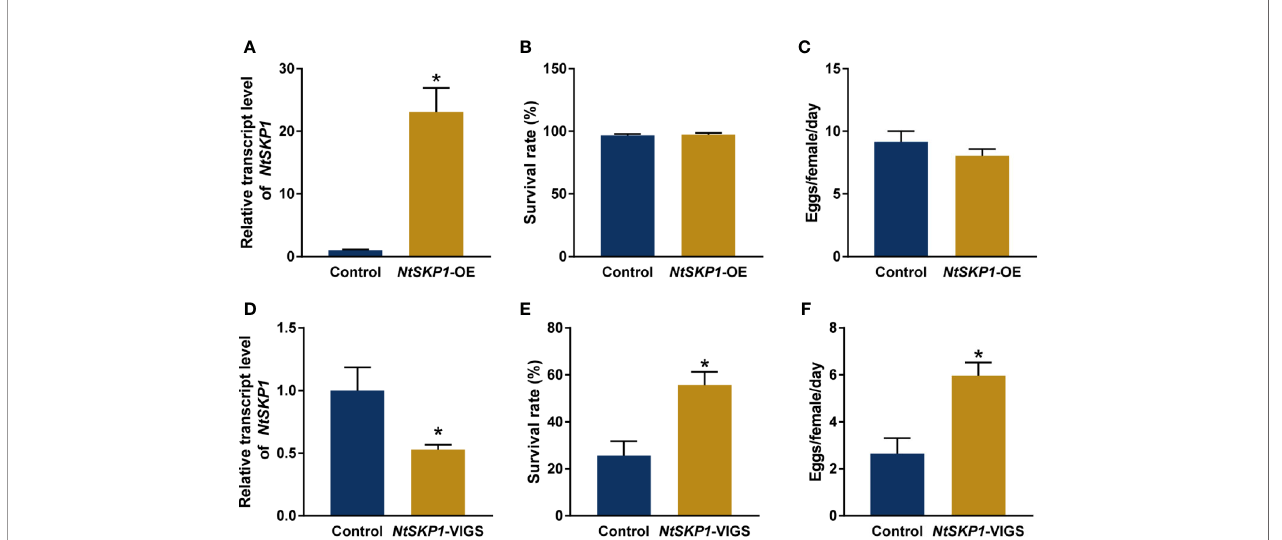
FIGURE 3 | NtSKP1 regulates tobacco defense against white fl y. (A) Relative transcript levels of NtSKP1 in control and NtSKP1 -overexpressed ( NtSKP1 -OE) tobacco plants. GFP or NtSKP1-GFP fusion proteins were transiently expressed in N. tabacum var. NC89. Total RNAs were extracted from each plant respectively at 48 h and subjected to qRT-PCR to quantify the mRNA levels of NtSKP1 . GAPDH was used as the internal reference. Values are mean ± SEM, n = 5. (B) Survival rates of white fl ies on control and NtSKP1 -overexpressed tobacco plants. GFP or NtSKP1-GFP fusion proteins were transiently expressed in N. tabacum var. NC89. Each cohort of fi ve females and fi ve males was released in a clip cage fi xed on the abaxial surface of tobacco leaf at 48 h. The numbers of live adults were counted 3 days later. Values are mean ± SEM, n = 20. (C) Average numbers of eggs one day laid by per female white fl y on control and NtSKP1 -overexpressed tobacco plants. GFP or NtSKP1-GFP fusion proteins were transiently expressed in N. tabacum var. NC89. Each cohort of fi ve females and fi ve males was released in a clip cage fi xed on the abaxial surface of tobacco leaf at 48 h. The numbers of eggs were counted 3 days later. Values are mean ± SEM, n = 20. (D) Relative transcript levels of NtSKP1 in control and NtSKP1 -silenced ( NtSKP1 -VIGS) tobacco plants. Gene silencing was achieved by VIGS assay. Total RNAs were extracted from each plant respectively and subjected to qRT-PCR to quantify the mRNA levels of NtSKP1 . GAPDH was used as the internal reference. Values are mean ± SEM, n = 5. (E) Survival rates of white fl ies on control and NtSKP1 -silenced tobacco plants. Gene silencing was achieved by VIGS assay. Each cohort of fi ve females and fi ve males was released in a clip cage fi xed on the abaxial surface of tobacco leaf. The numbers of live adults were counted 7 days later. Values are mean ± SEM, n = 30. (F) Average numbers of eggs one day laid by per female white fl y on control and NtSKP1 -silenced tobacco plants. Gene silencing was achieved by VIGS assay. Each cohort of fi ve females and fi ve males was released in a clip cage fi xed on the abaxial surface of tobacco leaf. The numbers of eggs were counted 7 days later. Values are mean ± SEM, n = 30. Student ’ s t test was used for signi fi cant difference analysis (* P <